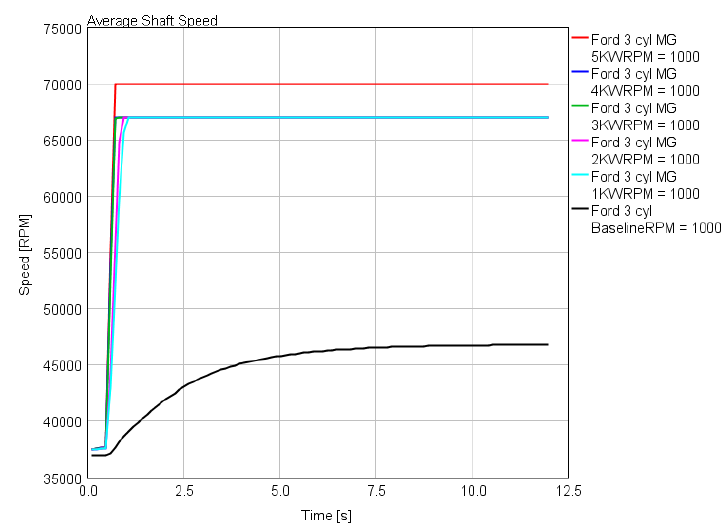
Figure 10. Turbocharger shaft speed at a 1000 rpm engine.